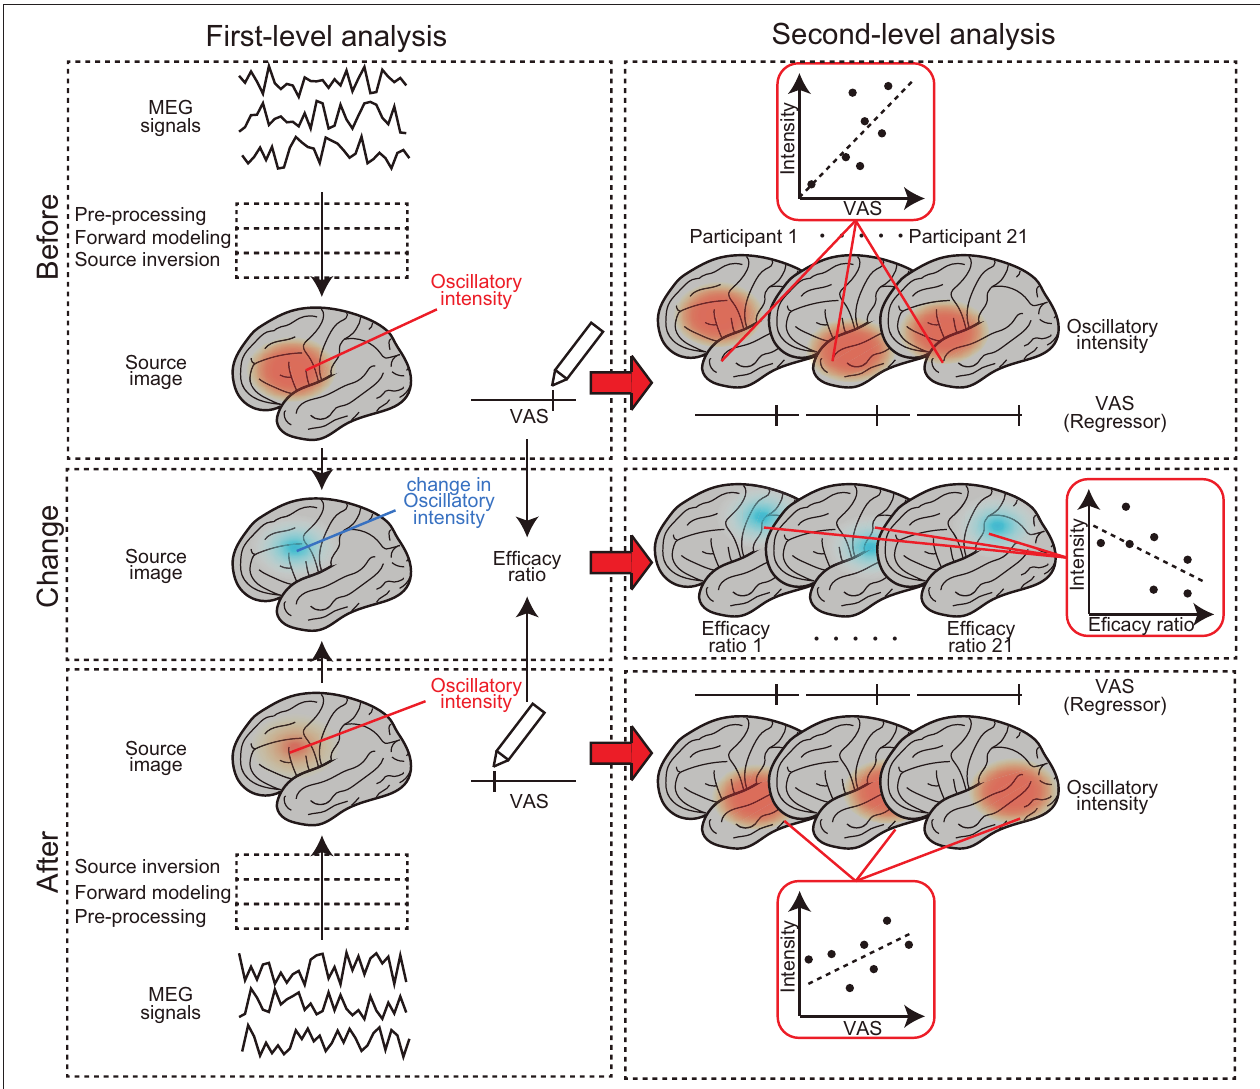
FIGURE 2 | Schematic representation of the MEG analysis pipeline. It consists of two major steps: first-level (left column) and second-level analyses (right column). The first-level analysis was performed participant-wise, to gain estimated regional brain activity signals at each frequency component. Second (group)-level analysis was performed to find brain regions where the subjective levels of pain (i.e., pre-VAS, post-VAS, and efficacy ratio) were associated with regional brain activity (i.e., oscillatory intensity) at each frequency component.